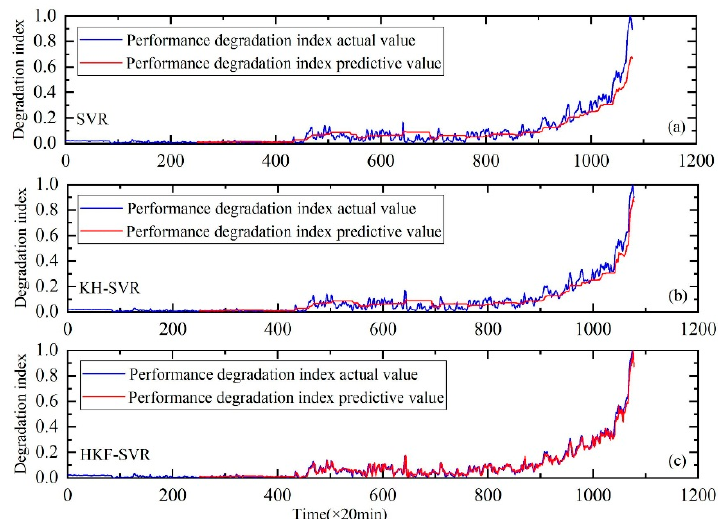
Figure 5. Performance degradation prediction of bearing 1. ( a ) is the result of SVR, ( b ) is the result of SVR with parameters optimized by the KH algorithm and ( c ) is the result of HKF–SVR with parameters optimized by the KH algorithm.